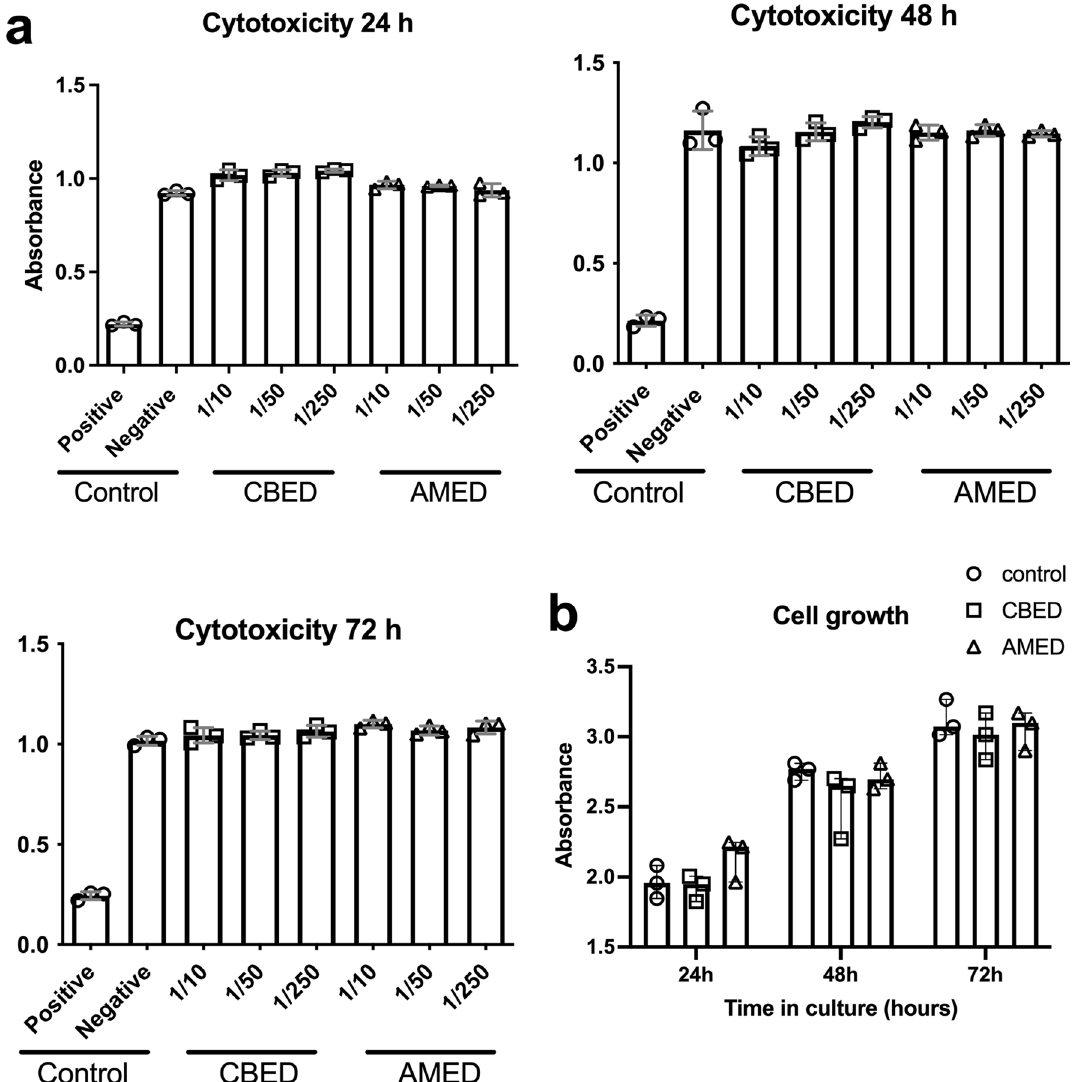
Figure 1. In vitro cytotoxicity and cellular growth assays performed with HCE cells. ( a ) Cytotoxicity was measured at 24, 48 and 72 h as a function of absorbance in a WST assay. Preparations were used at 1:10, 1:50 and 1:250 dilutions. SDS (0.02%) was used as a positive control (for cytotoxicity) and FBS (10%) as negative control. There are no statistically significant differences between any of the dilutions and the negative control (Mann–Whitney test used) ( b ) Cell growth was measured as a function of absorbance in a crystal violet elution assay. Absorbance is directly related to the cell density on the plates. Cells grown in either FBS (control), CBED or AMED have no statistically significant differences in cell densities after 24, 48 and 72 h of culture (2-way multiple comparison ANOVA with Tukey’s post-hoc test Methods). The reported concentrations are the mean of 10 independent batches (from 10 different donors) each measured in triplicate. The two preparations have different profiles. The concentrations of all factors measured was higher in CBED than AMED except that of basic fibroblast growth factor (bFGF). We observed variability in GF concentrations between samples (donors), which is reflected in the standard deviations (SDs) reported. Neither CBED or AMED were cytotoxic and both improved in vitro cell growth. Neither CBED nor AMED showed cytotoxic effects on HCE cells at any of the dilutions or time points (24–72 h) assessed using the WST1 cytotoxicity assay (Fig. 1a). The absorbance levels observed are comparable to those of the negative control (FBS) and well above those of the SDS treated cells (positive control). Using the colorimetric cellular mass approach crystal violet dye elution assay, we demonstrated that both CBED and AMED are capable of sup- porting cell growth . At 1/10 dilution in 5% FBS supplemented medium, both presented similar cell growth rates to those of control 10% FBS supplemented complete medium at all assayed time points (Fig. 1b).